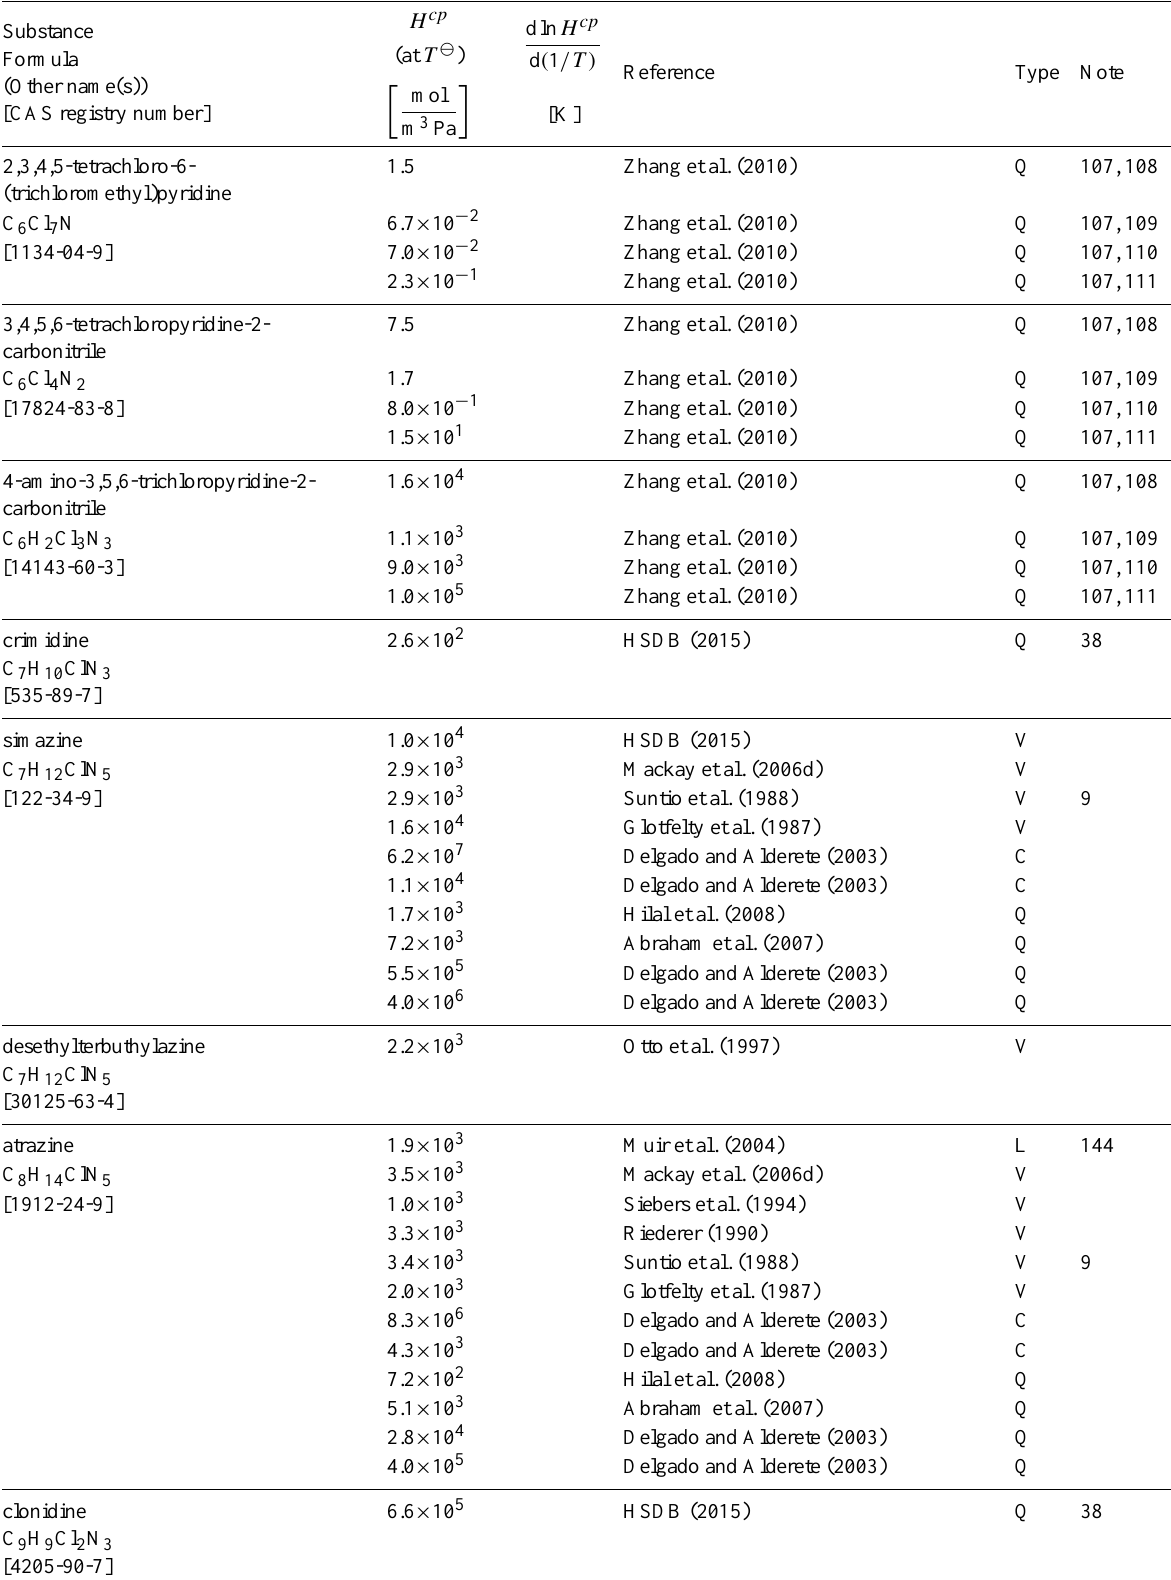
Table 6: Henry’s law constants for water as solvent